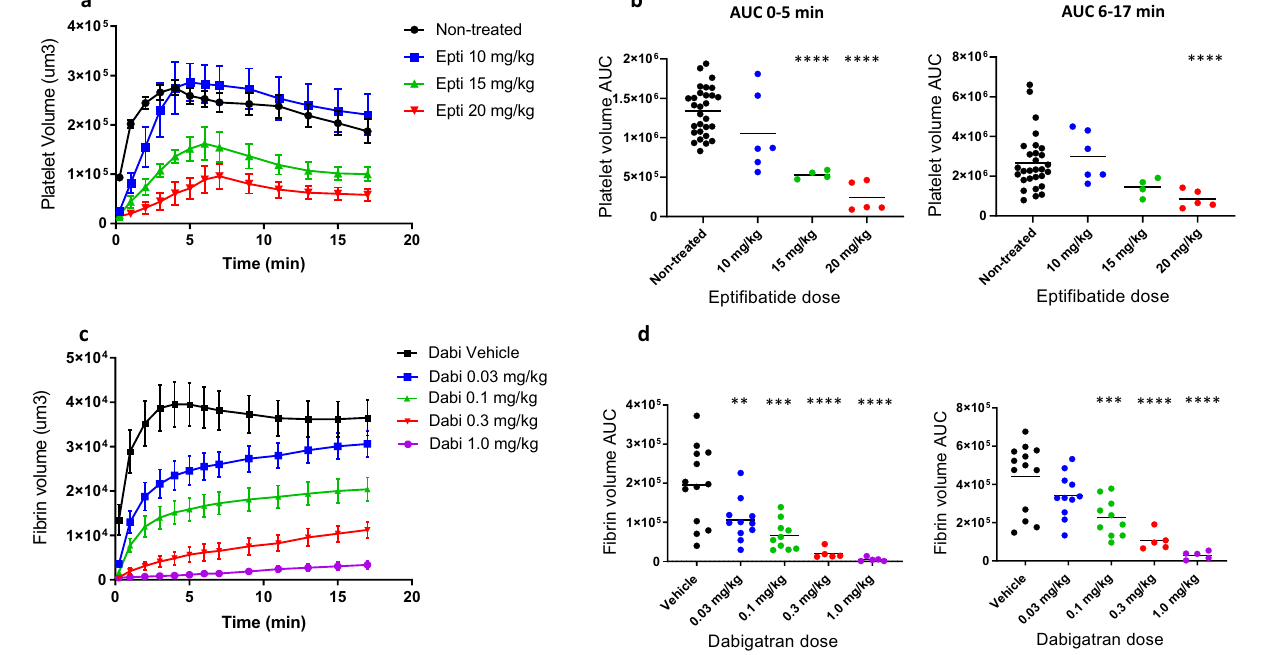
Figure 6. The scanning-LIEI model can be used to describe dose–response effects of anti-thrombotic drugs. Mice were treated with a bolus dose of the GPIIbIIIa inhibitor eptifibatide (Epti 10, 15, 20 mg/kg), vessel injuries were created using the scanning-LIEI protocol and platelet volume was measured at indicated time points. ( a ) Effects of eptifibatide on platelet accumulation (platelet volume) over time (mean +/− SEM). ( b ) Effect of eptifibatide on platelet volume AUC during the growth phase (0–5 min left panel) and maturation phase (6–17 min right panel). Number of injuries (mice) were as follows: Control = 29(15), Epti 10 mg/kg = 6(6), Epti 15 mg/kg = 4(4), Epti 20 mg/kg = 5(5). The mean of each group is displayed in the scatter plots. Due to the log-normal data distribution seen in the maturation phase this data set was log-transformed before subjected to one-way ANOVA. Mice were treated with a bolus dose of the direct thrombin inhibitor dabigatran (Dabi 0.03, 0.1, 0.3, 1 mg/kg) or vehicle and fibrin volume was measured at indicated time points. ( c ) Effect of dabigatran on fibrin volume over time (mean +/− SEM). ( d ) Effect of dabigatran on fibrin volume AUC during the growth phase (0–5 min left panel) and maturation phase (6–17 min right panel). Number of injuries (mice) were as follows: Vehicle = 13(6), Dabi 0.03 mg/kg = 11(4), Dabi 0.1 mg/kg = 10(4), Dabi 0.3 mg/kg = 5(2), Dabi 1 mg/ kg = 5(2). The mean of each group is displayed in the scatter plots. ** p < 0.01, *** p < 0.001, **** p <